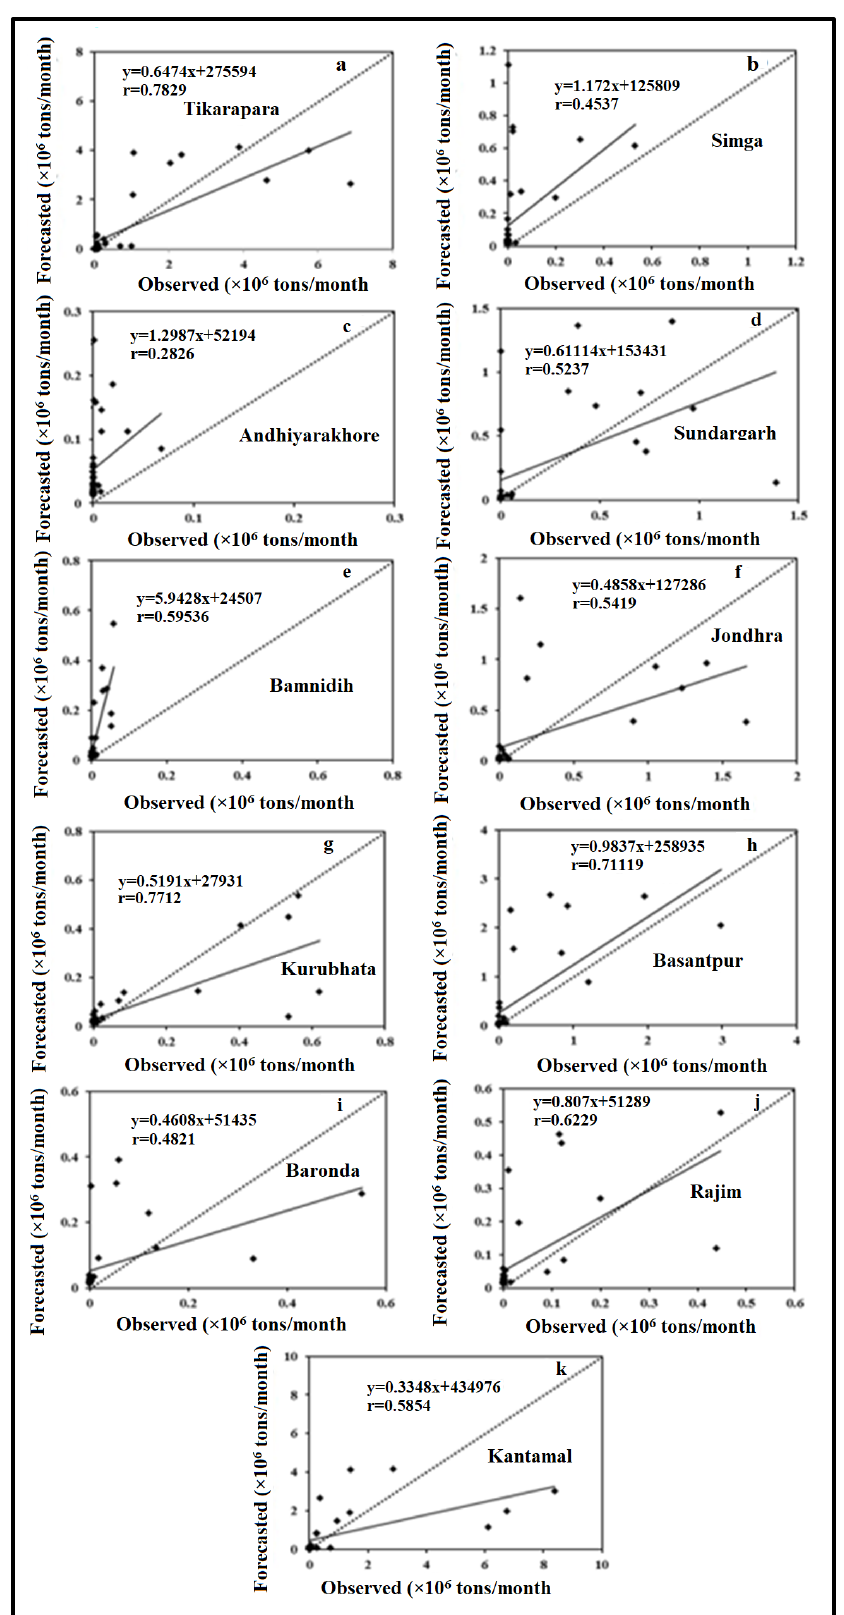
Figure 7. Scatter plot of forecasted and observed SSY from GA-ANN-51 forecasting model in a testing phase (a-k).